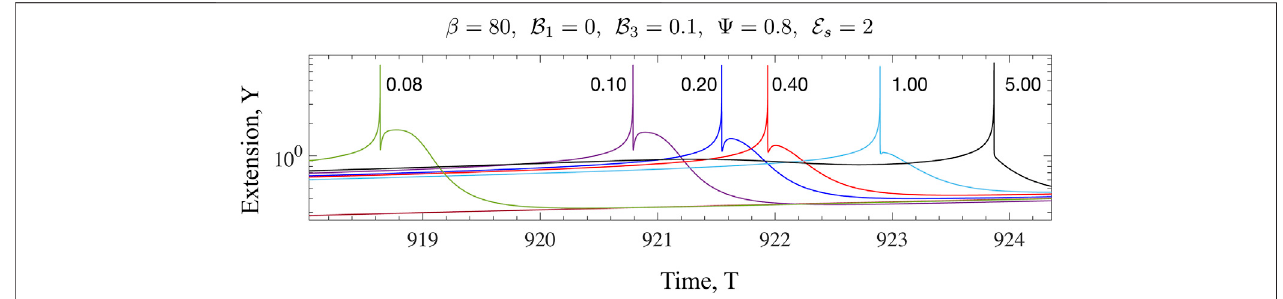
FIGURE10 | The effect ofincreased dissipation (viscosity) on the form of Y ( T ) for the Maxwell model isillustrated here. The value of β is much largerthan thecritical valuefortheonsetofoscillations.Fixing